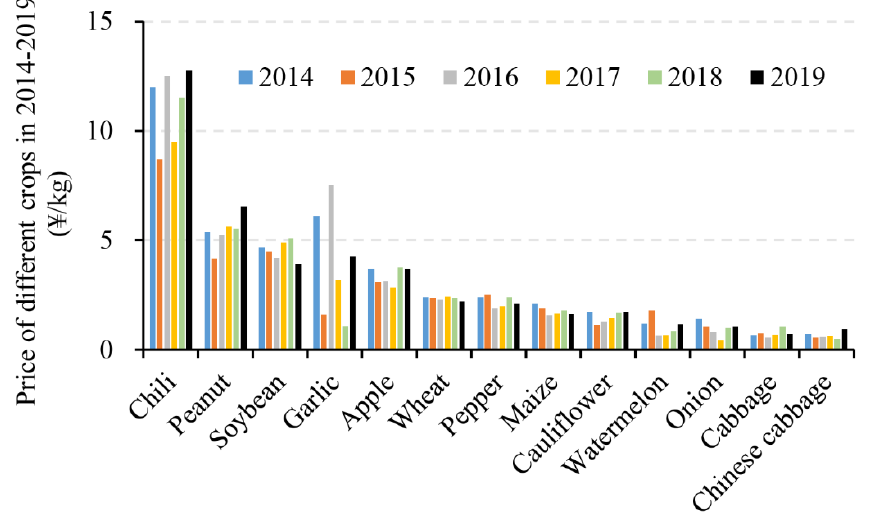
Figure 9. Selling prices by farmers of different crops in 2014–2019. The EEW i U values for different crops from 2014 to 2019 are shown in Table 4, and the distribution of the highest and lowest values was almost the same as the distribution of crop price. The highest multi-year average values were 50.59 ¥/m 3 for apples and 5.04 ¥/m 3 for wheat. The EEW i U for apples remained relatively high, with the lowest value still being 42.7 ¥/m 3 in 2017, while that for wheat was approximately 5.00 ¥/m 3 year-round. Although the EEW i U values for wheat and maize were not very high, they were relatively stable compared with those of vegetables. Although the values for vegetables were relatively high, they fluctuated greatly; for instance, the EEW i U of garlic reached a maximum of 39.69 ¥/m 3 and a minimum of 8.47 ¥/m 3 . Table 4. Economic efficiency of irrigation water in 2014–2019.